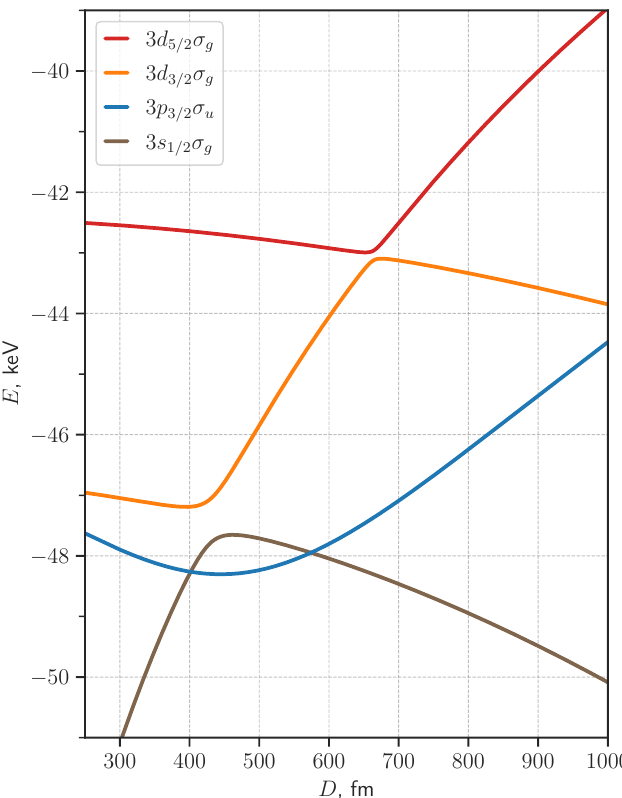
Figure 2. Electronic terms of the one-electron Pb 82 + –Pb 82 + quasimolecule. Energies of states with n = 6, . . . ,9